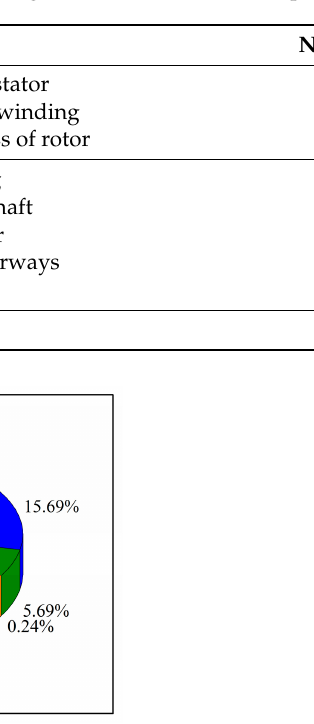
Table 5. Simulation results of electromagnetic losses of motor components at 80,000 rpm.